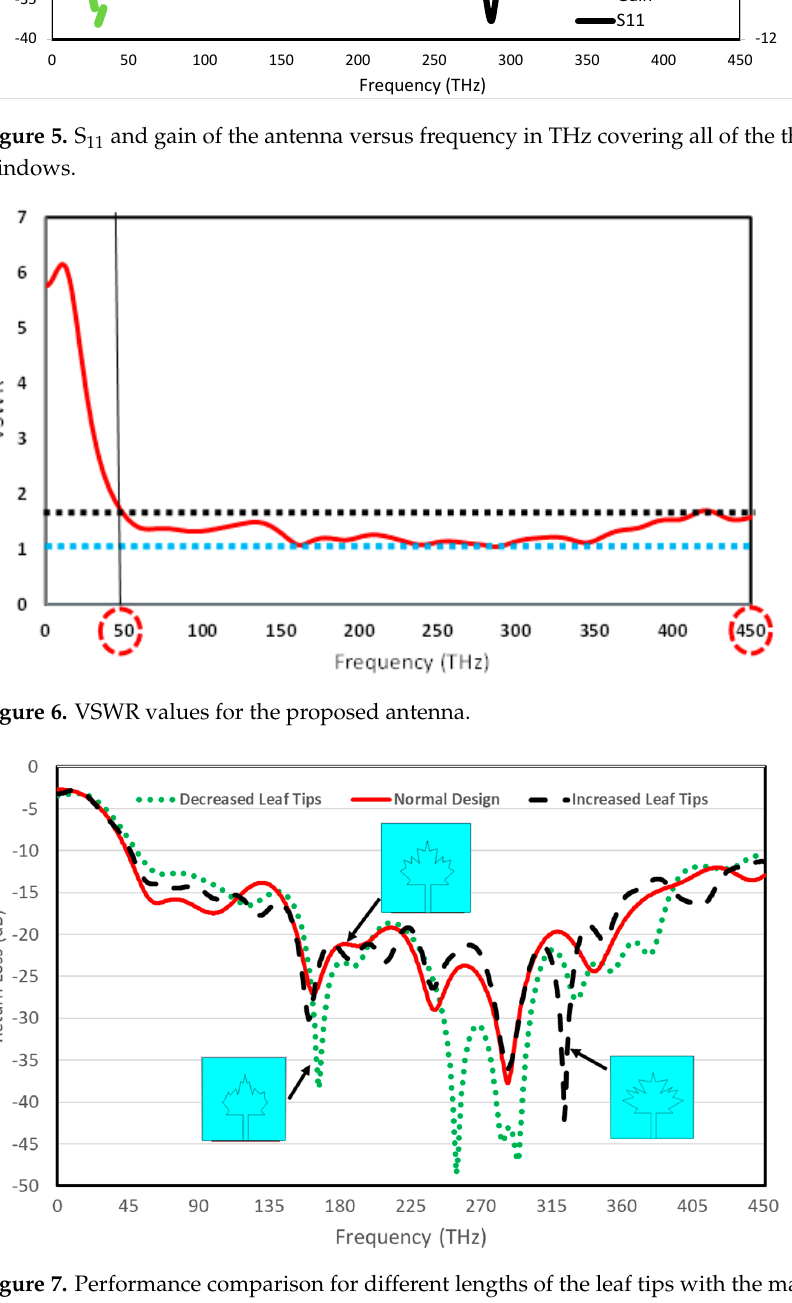
( d ) Figure 8. Gain plot in the E and H planes at ( a ) 193 THz; ( b ) 229 THz; ( c ) 353 THz; ( d ) 390 THz.